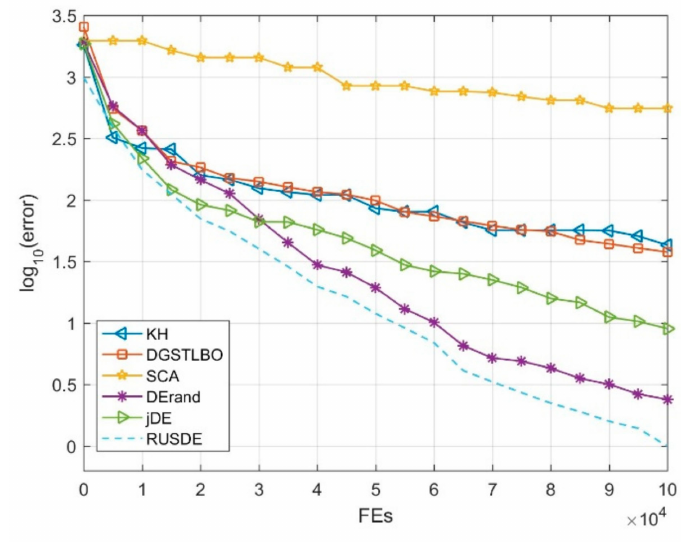
Figure 3. Convergence curves of the four-bar mechanism with the six